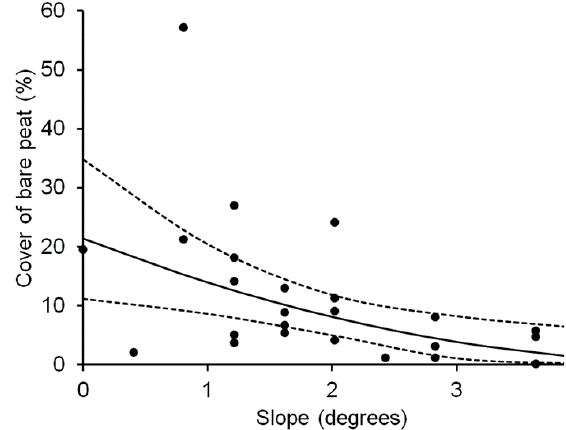
Figure 5. The relationship between slope and bare peat cover, as observed (black circles) and fitted (line, with 95 % confidence intervals). The fitted relationship is based on the reduced model (Table 2).